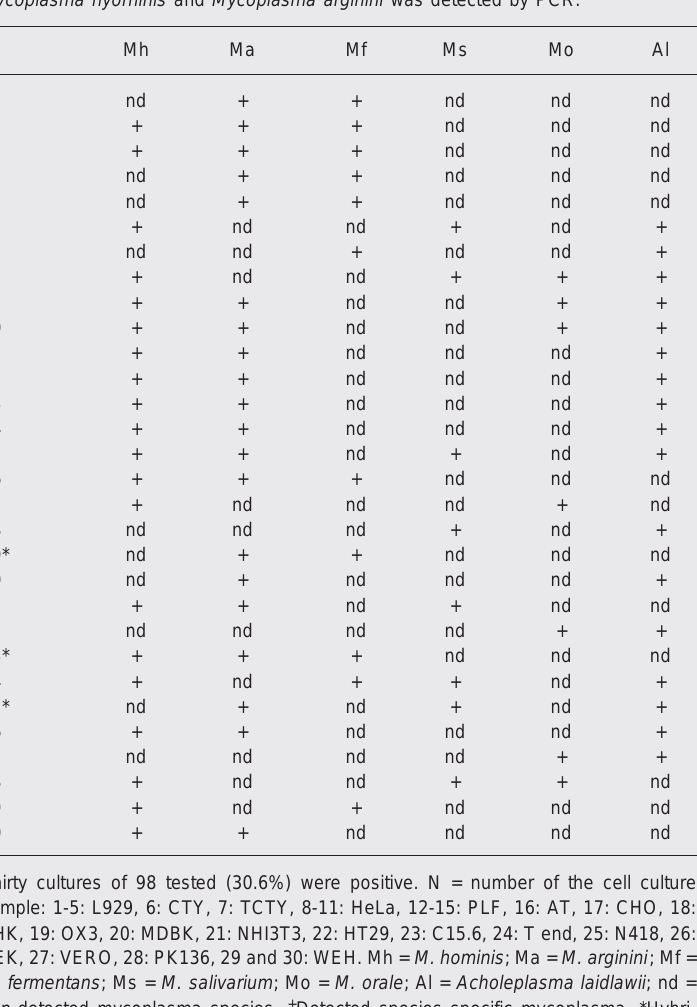
Table 2. Cell cultures in which more than one species of mycoplasma other than Mycoplasma hyorhinis and Mycoplasma arginini was detected by